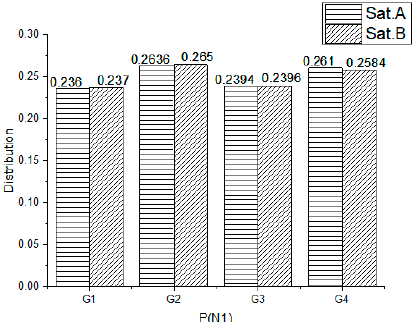
Figure 14. Conditional distribution of N1.